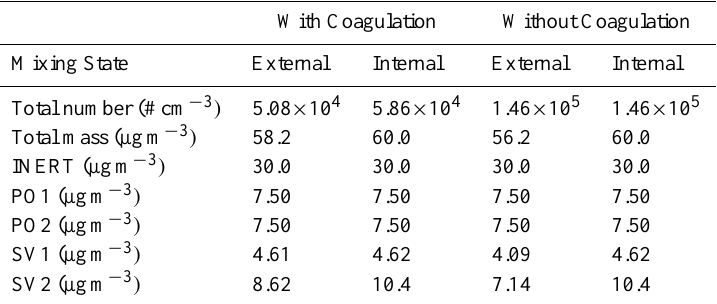
Table 3. Total number, mass, and compound concentrations at t =188 h for base case scenario with external and internal mixtures, with and without